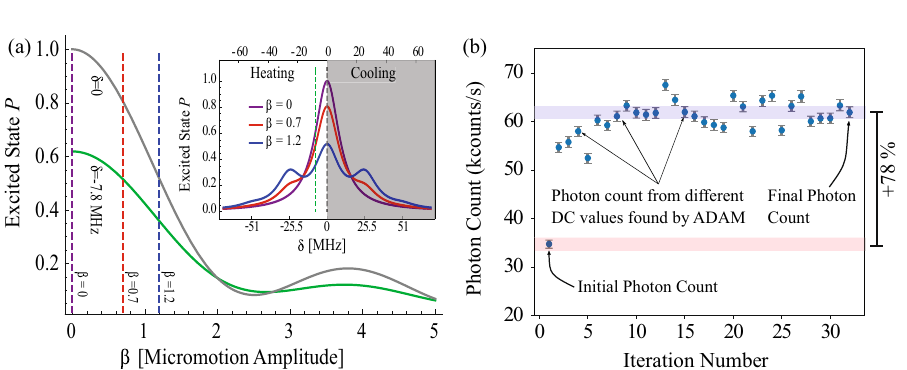
Figure 2. ( a ) Ideal micromotion broadening of the transition fluorescence in a two-level system as a function of the micromotion amplitude [ β ] and laser detuning ( δ ) in the low intensity limit (Eq. 1). For our 370 nm transition the fluorescence rate is proportional to the 2 P 1 / 2 excited state population. The laser frequency detuning δ = − 7.8 MHz, the natural linewidth γ = 20 MHz and the RF trap drive frequency (cid:31) = 25.5 MHz. Heating/cooling dynamics are neglected. Our optimizations occur in the low beta ( < 1 ) limit. ( b ) The photon count improvement using ADAM starting from manually optimized voltage set weights. This graph demonstrates a 78 ± 1% improvement in ion fluorescence. The error bars are a combination of the readout error of the PMT and peak to peak variations in the photon count whilst not optimizing. The background photon count here is 1184 ± 34